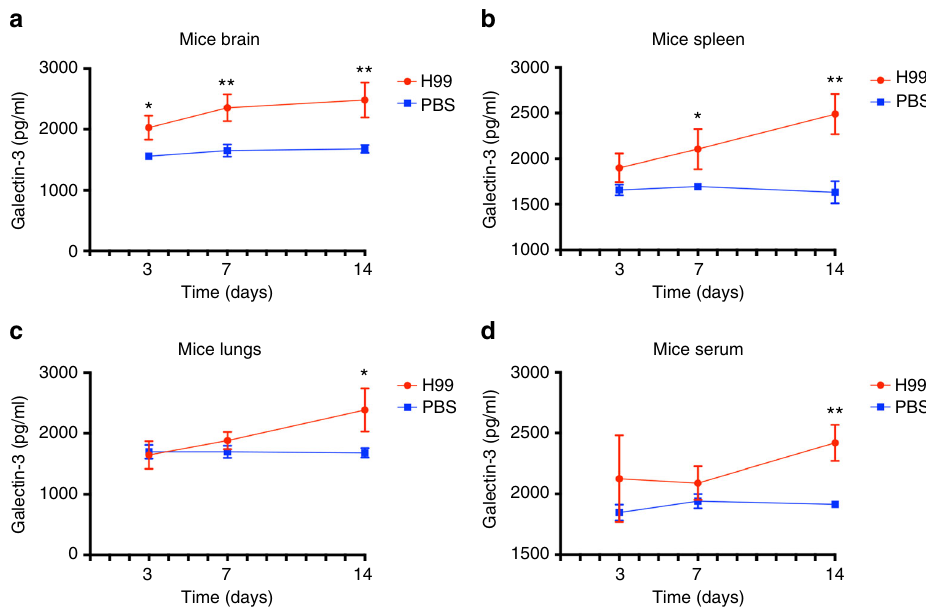
Fig. 1 Upregulated Gal-3 levels in mice during experimental C . neoformans infection. C57BL/6 mice were intratracheally infected with H99 yeast cells (red line with circle) or PBS (blue line with square) and Gal-3 levels were veri fi ed in tissues and serum during the course of C . neoformans infection. On days 3, 7, and 14 after the fungal inoculation, samples collected of brain ( a ), spleen ( b ), lungs ( c ), and serum ( d ), were homogenized and assessed by ELISA regarding the Gal-3 concentration. Gal-3 levels were upregulated over time after infection with C . neoformans . Bars represent the mean ± SD of Gal-3 levels obtained from triplicate samples in groups of fi ve animals. Statistically signi fi cant differences are denoted by asterisks (* p < 0.05, ** p < 0.005, unpaired Student ’ s t